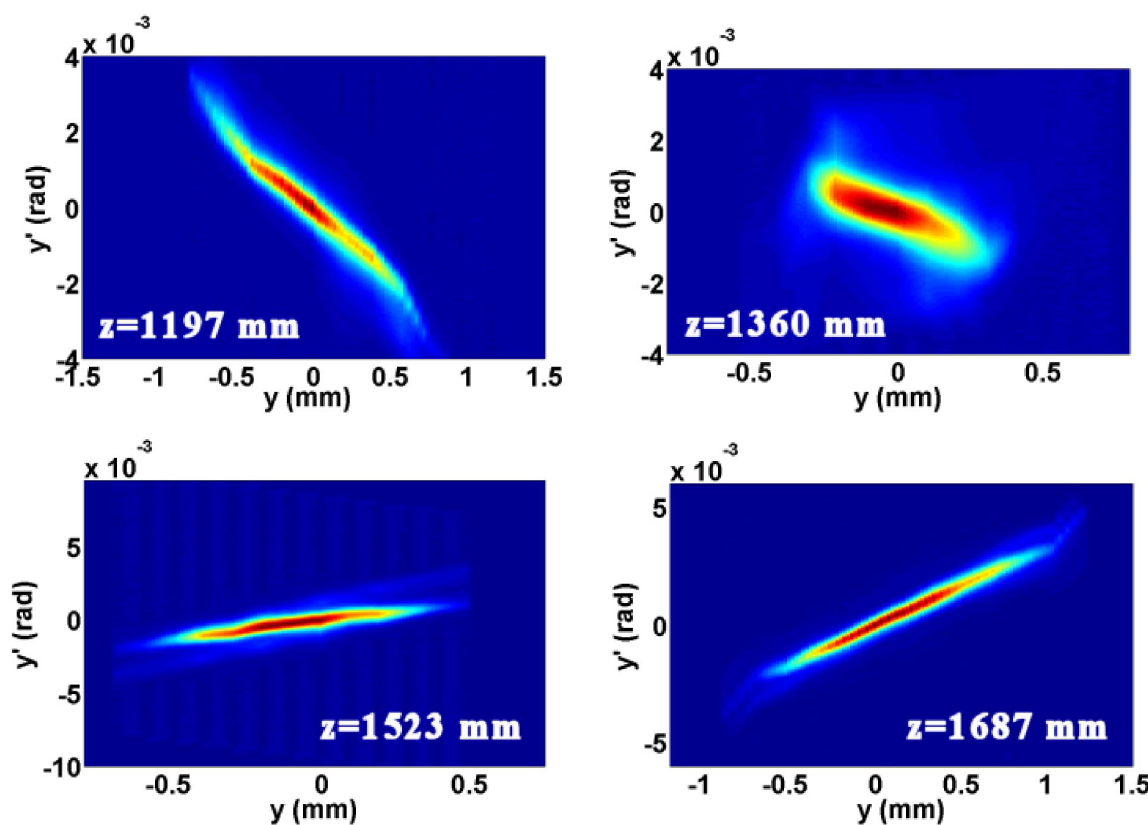
FIG. 7. (Color) Example of phase-space evolution. Data from measurements of run #29 reported later in the